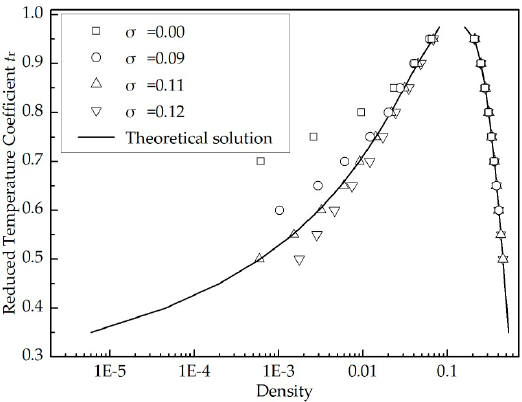
Figure 4. Comparison of the numerical coexistence curves with the theoretical solutions.